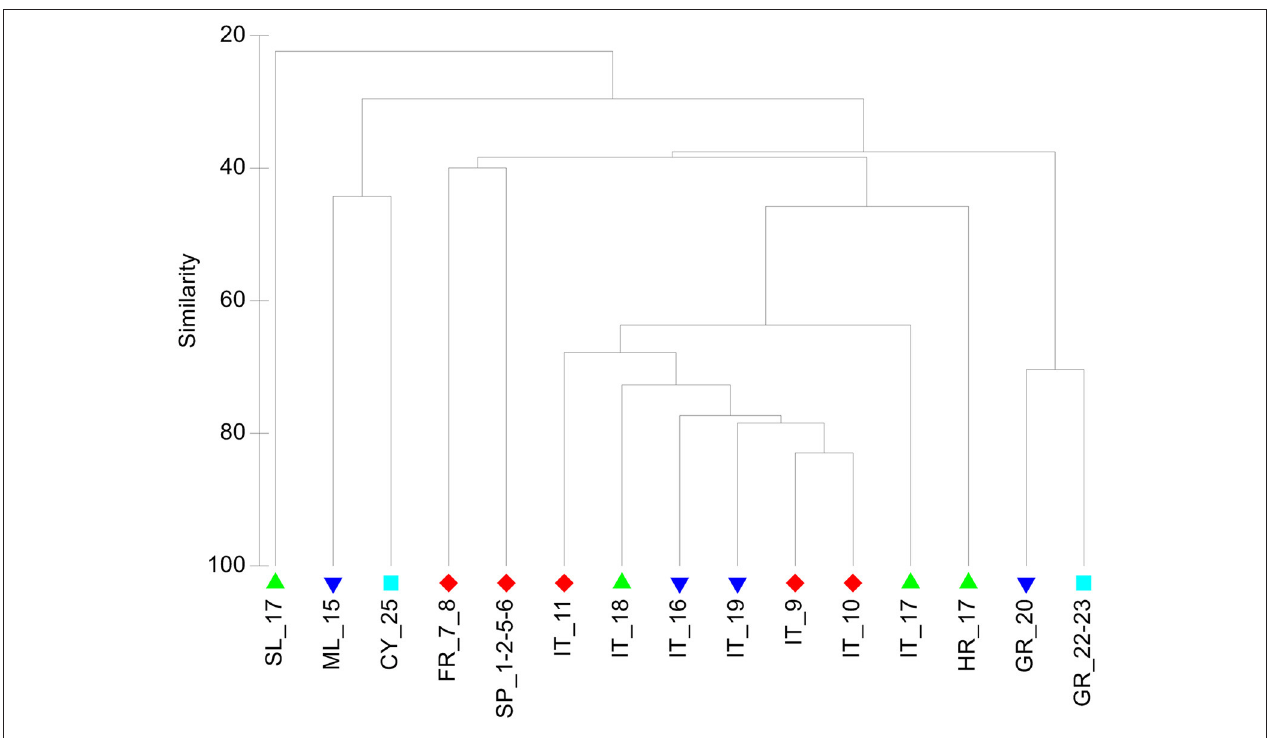
FIGURE 3 | Cluster analysis (group average, based on Bray–Curtis similarity matrix) of landings composition per species and assessment areas (fourth root transformation) within the MSFD Initial Assessment in the Mediterranean Region. : Western Mediterranean Sea; : Adriatic Sea; : Ionian Sea and Central Mediterranean; : Aegean-Levantine Sea. Assessment areas codes are reported in Table 3 .